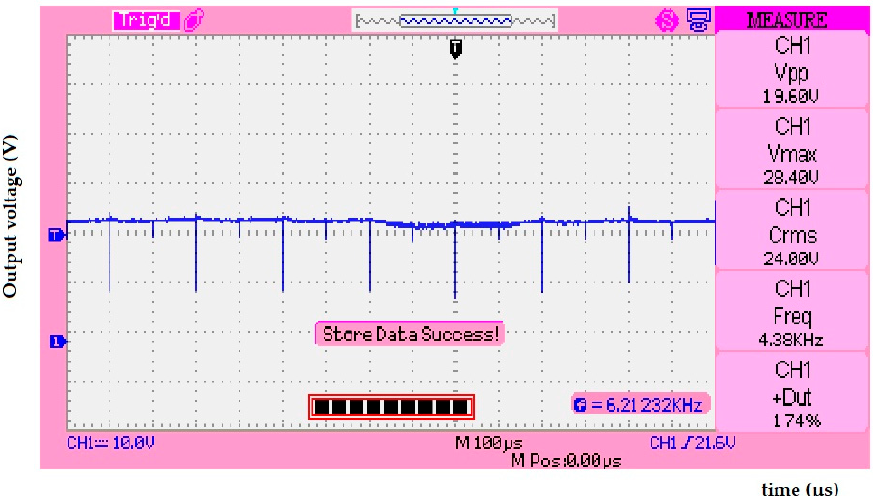
Figure 10. Load output voltage waveform.